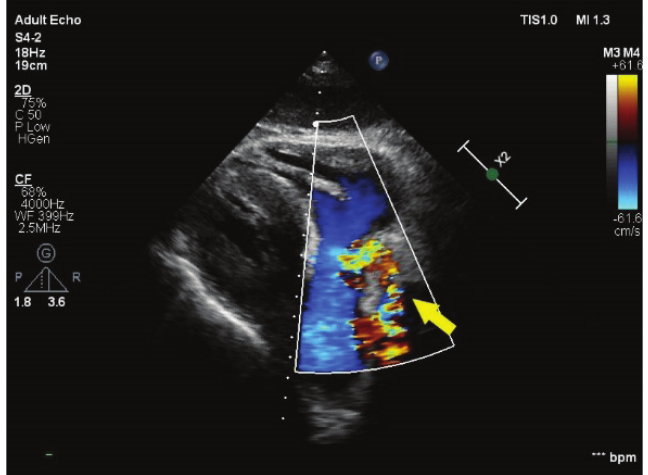
3x20 mm fistula tract from different views (Figure 4,5).